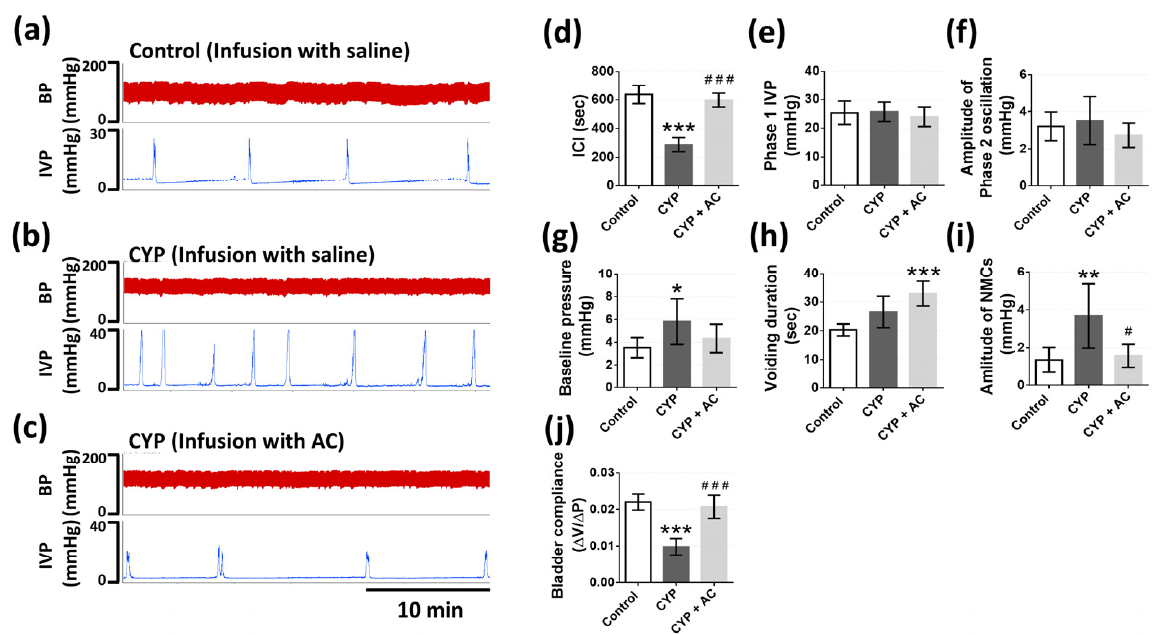
Figure 9. The effects of CaSR agonist (AC) on cyclophosphamide (CYP)-induced bladder hyperactivity. The recording of IVP in control group ( a ), CYP group with intravesical infusion of saline ( b ), and CYP group with intravesical infusion of AC (CYP + AC) ( c ). The statistical analysis of bladder function parameters in control group, CYP group with intravesical infusion of saline and AC, including ICI ( d ), phase 1 IVP ( e ), amplitude of phase 2 oscillation ( f ), baseline pressure ( g ), voiding duration ( h ), amplitude of NMCs ( i ), and bladder compliance ( j ) (One-way ANOVA with Tukey’s post hoc tests, n = 6 for each group; * p < 0.05, ** p < 0.01, *** p < 0.001, as compared with control group; # p < 0.05, ### p < 0.001, as compared with CYP group).